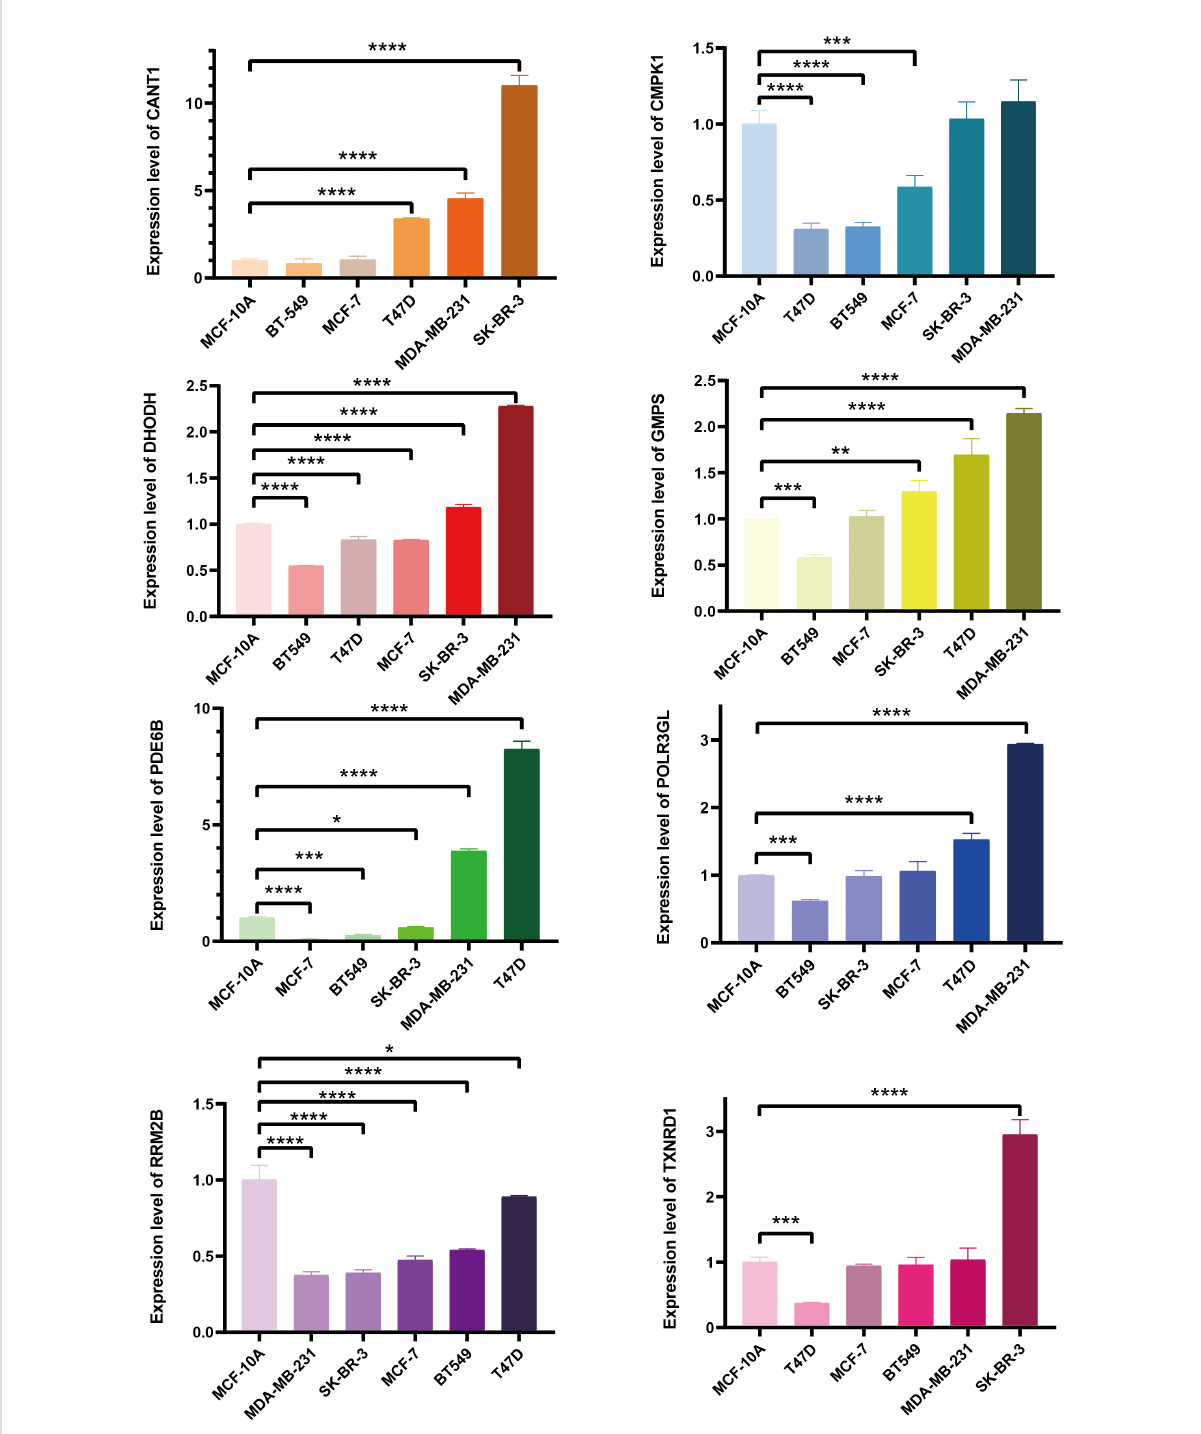
FIGURE 4 The mRNA expression levels of selected genes were detected in human BC cell lines and the normal mammary epithelial cell line. *p < 0.05; **p < 0.01; ***p < 0.001; ****p <